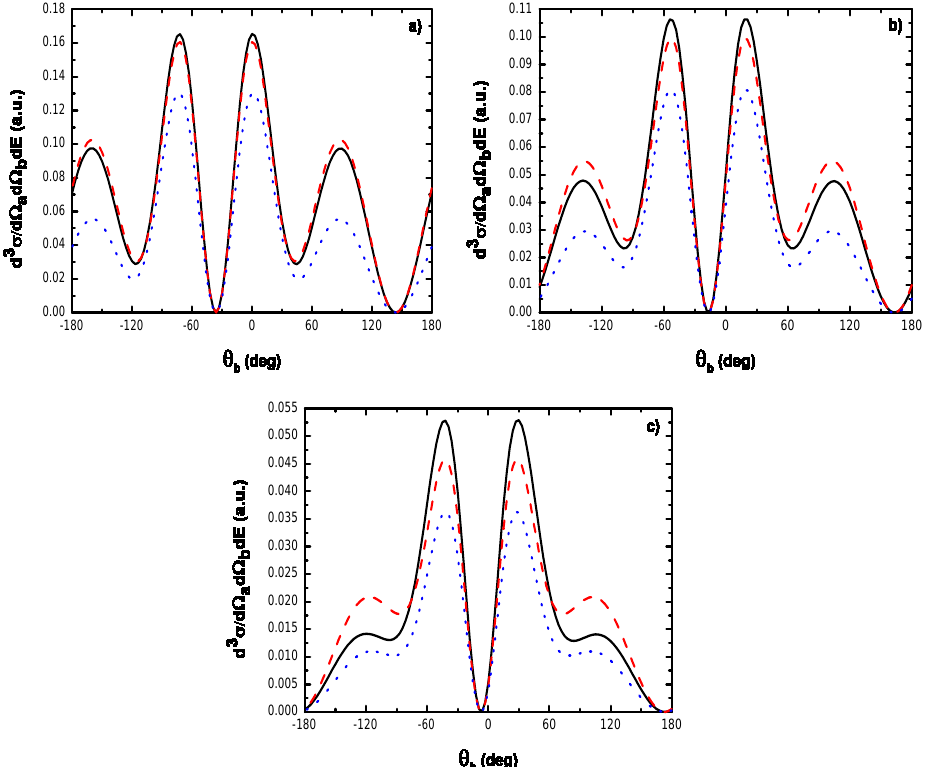
Figure 10. The same as in Figure 6, but the laser polarization vector is perpendicular to the momentum transfer ( ˆ ε ⊥ ∆ )